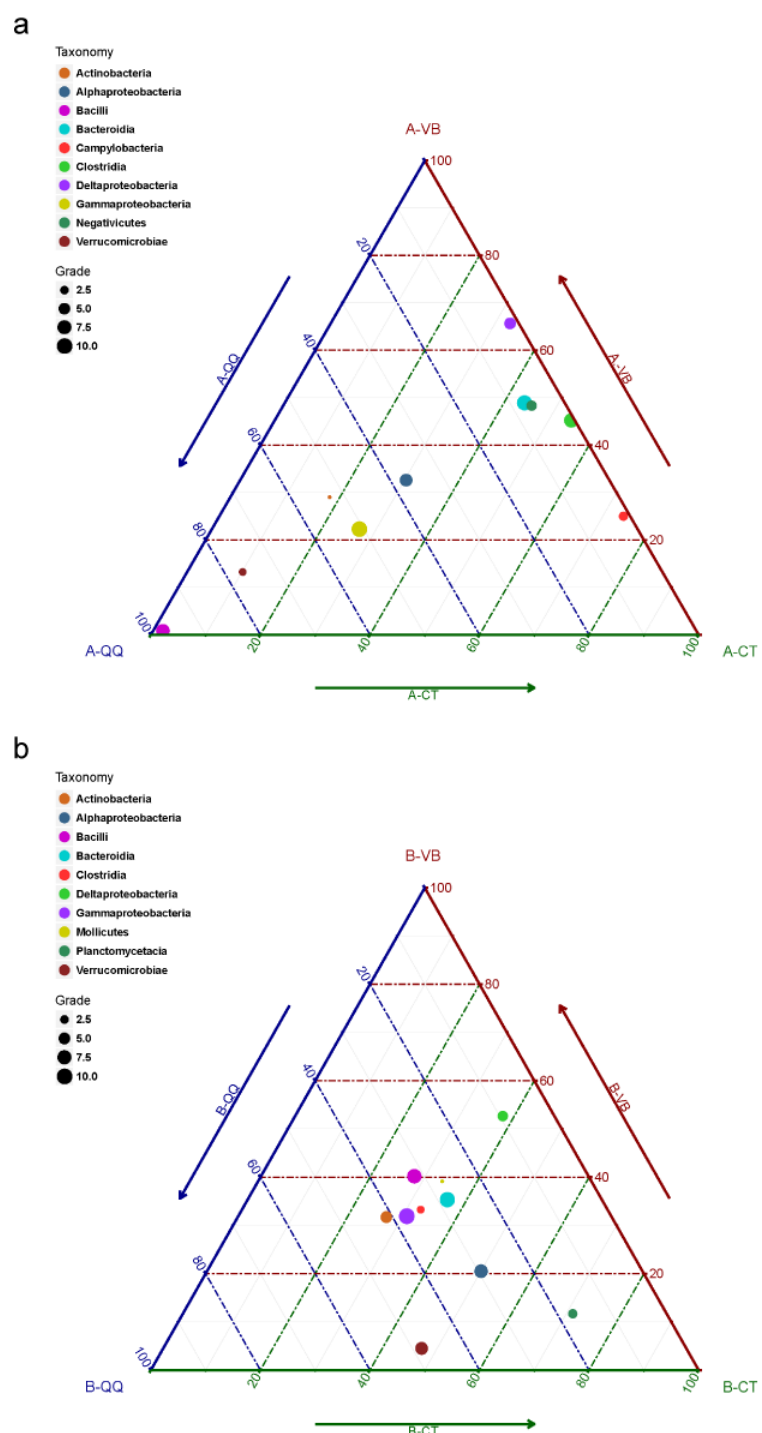
Figure 5. Ternary plot depicting the top 10 operational taxonomic units (OTUs) categorized under the class level with the highest relative abundance. ( a ) Activated sludge with quorum quenching (QQ) beads (A-QQ), vacant beads (A-VB), and control (A-CT), ( b ) biofilms formed on the membrane surface with QQ beads (B-QQ), vacant beads (B-VB), and control (B-CT). Grade represents the relative abundance (RA) of each bacteria, and a bigger grade number indicates a larger RA.